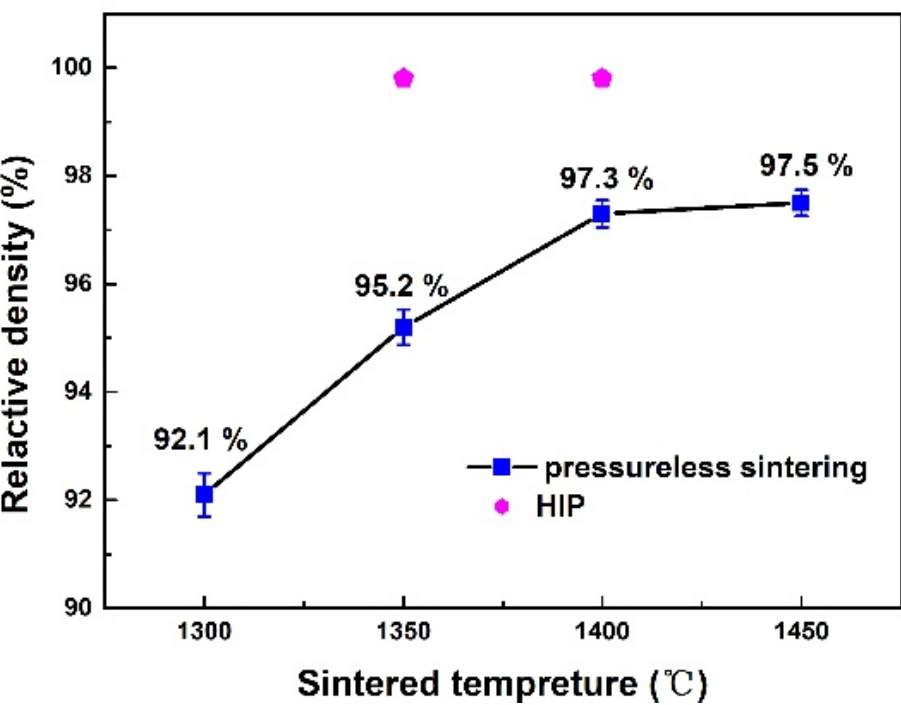
Figure 5. Relative densities of samples sintered at different temperatures.